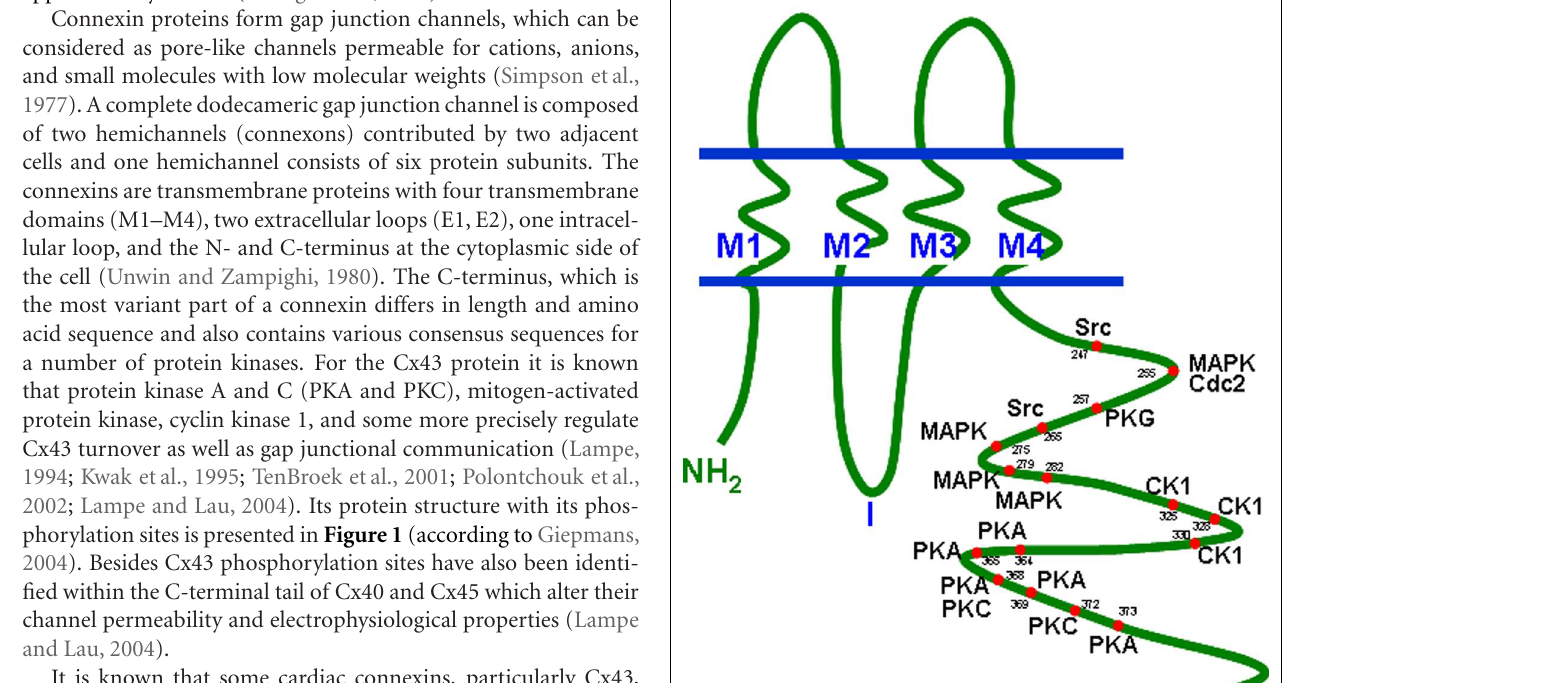
the lateral border of the cells but at lower abundance. This results in a fast conduction along the fiber axis and a slower conduction transverse to the axis (Dhein et al.,